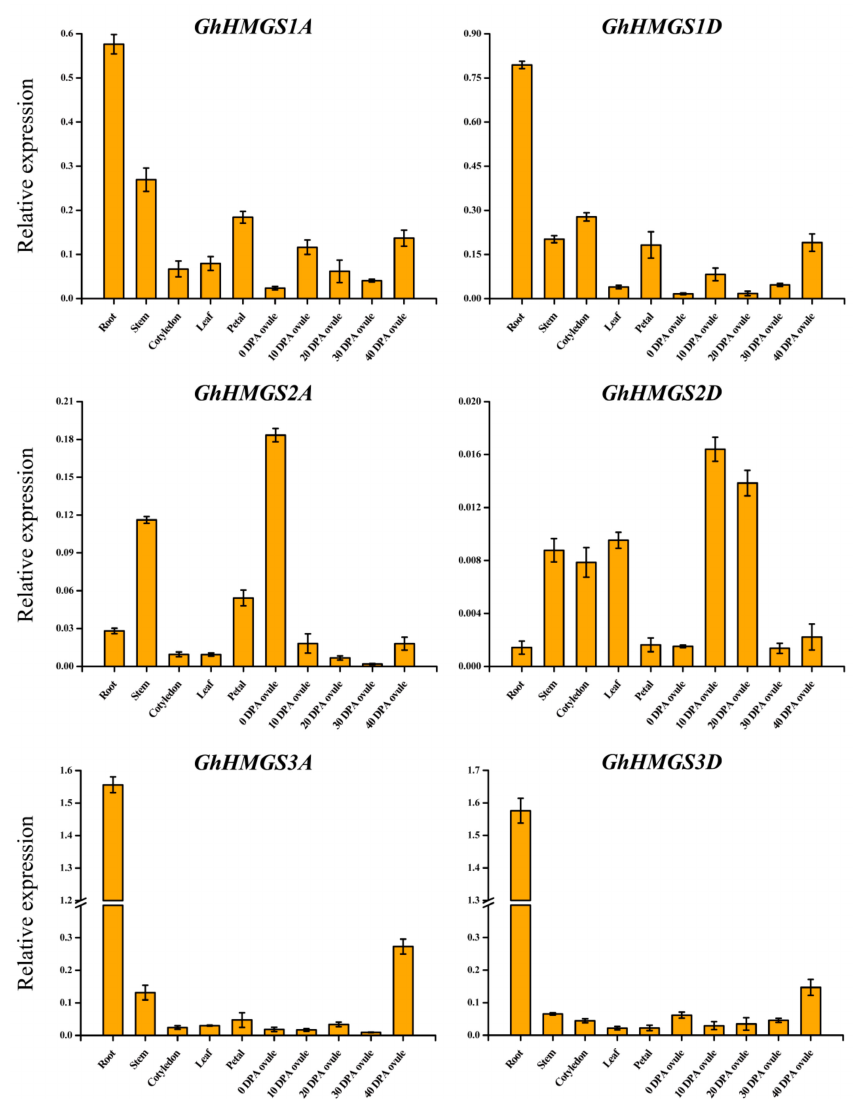
Figure 4. Expression analysis of G. hirsutum HMGS genes in various tissues. The expression patterns of GhHMGS genes were detected in the roots, stems, cotyledons, leaves, petals, and ovules (0, 10, 20, 30, and 40 DPA) and calculated with the cotton UBQ7 gene as an internal control. Error bars represent the standard deviations estimated from three independent